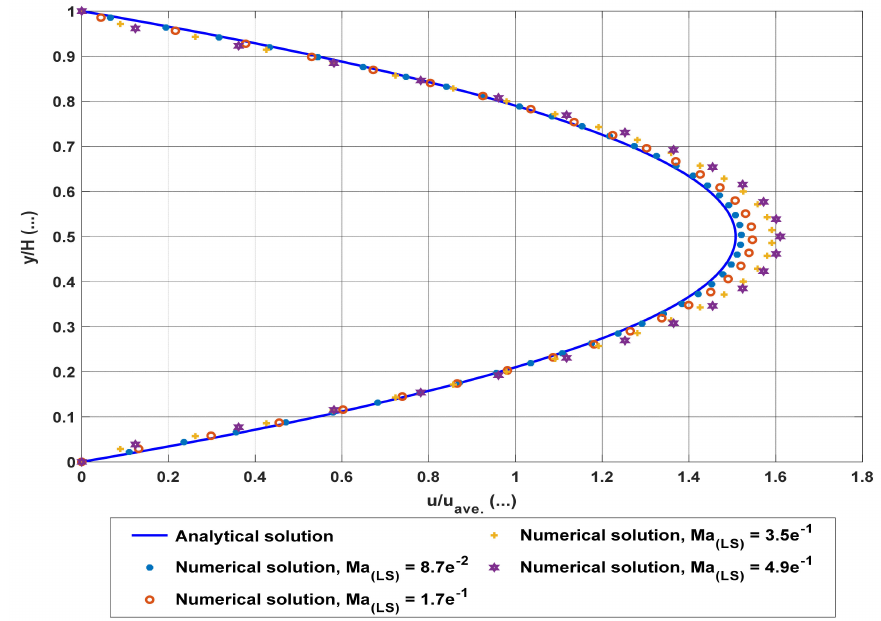
Figure 10. Effect of the lattice Mach number ( Ma ( LS ) ) on the accuracy of the LBM. Table 8. Converting data for the differentially heated square cavity example. The values with * represent assumed values. Reference Variables in Physical-Scale and